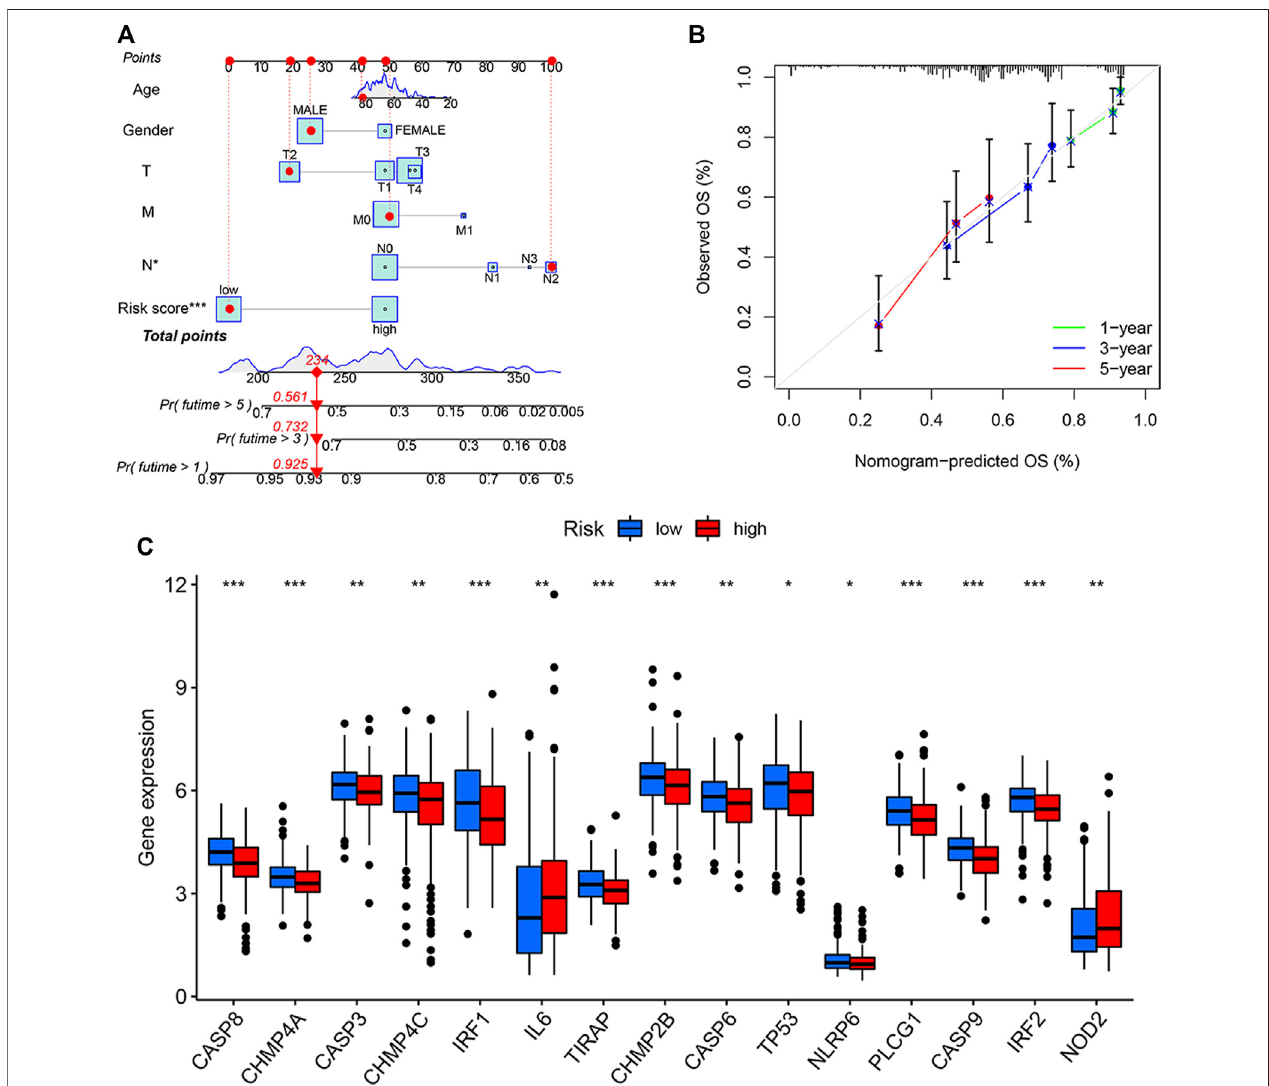
FIGURE 4 | Generation and validation of a predictive nomogram. (A) The nomogram of the risk score and clinical characteristics including age, gender, and the TMN stage in the training cohort. (B) The calibration curves showed good concordance between nomogram-predicted and observed overall survival (OS). (C) Differentially expressed gene(DEGs)expressions ofPRGsinpatients withhigh orlowpyroptosis-related gene(PRG) riskscores. *p < 0.05, **p < 0.01, and ***p < 0.001. T, tumor; M, metastases; N, nodes.